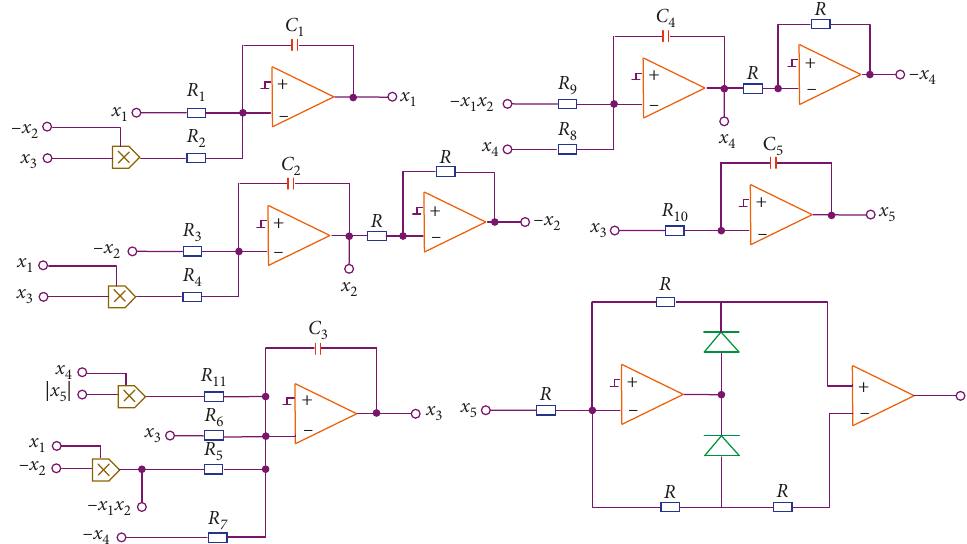
Figure 7: Hardware circuit implementation of the four-wing memristive hyperchaotic system